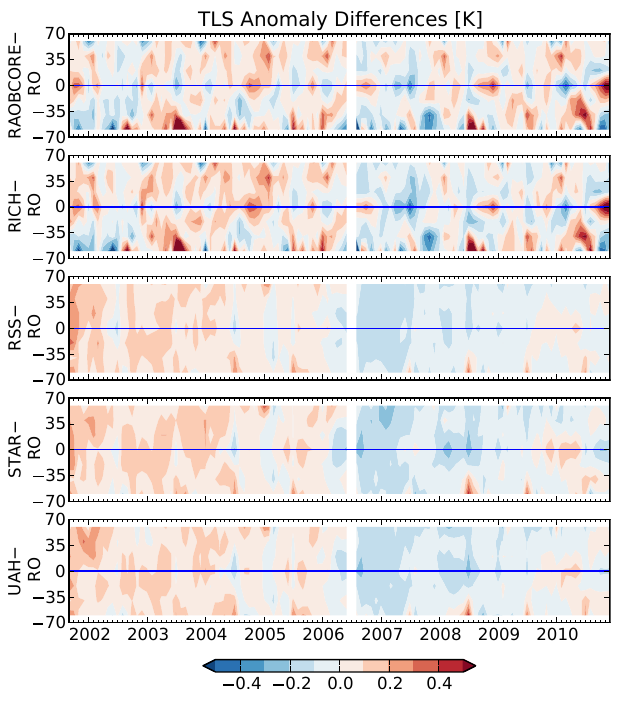
Fig. 9. Evolution of TLS anomaly differences of radiosonde (RAOBCORE, RICH) and (A)MSU (RSS, STAR, UAH) datasets to RO at 20 ◦ resolution (top to bottom).